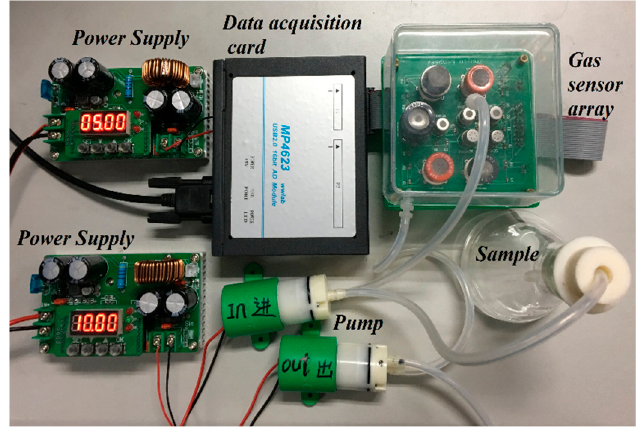
Figure 1. The hardware system of the electronic nose.